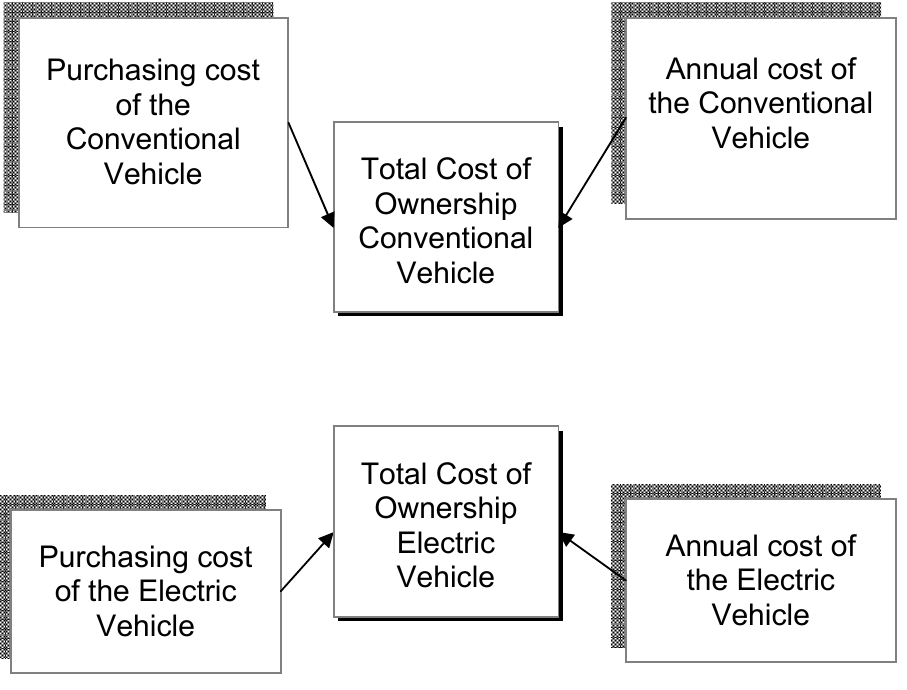
Figure 3. Schema of the electric vehicle block.